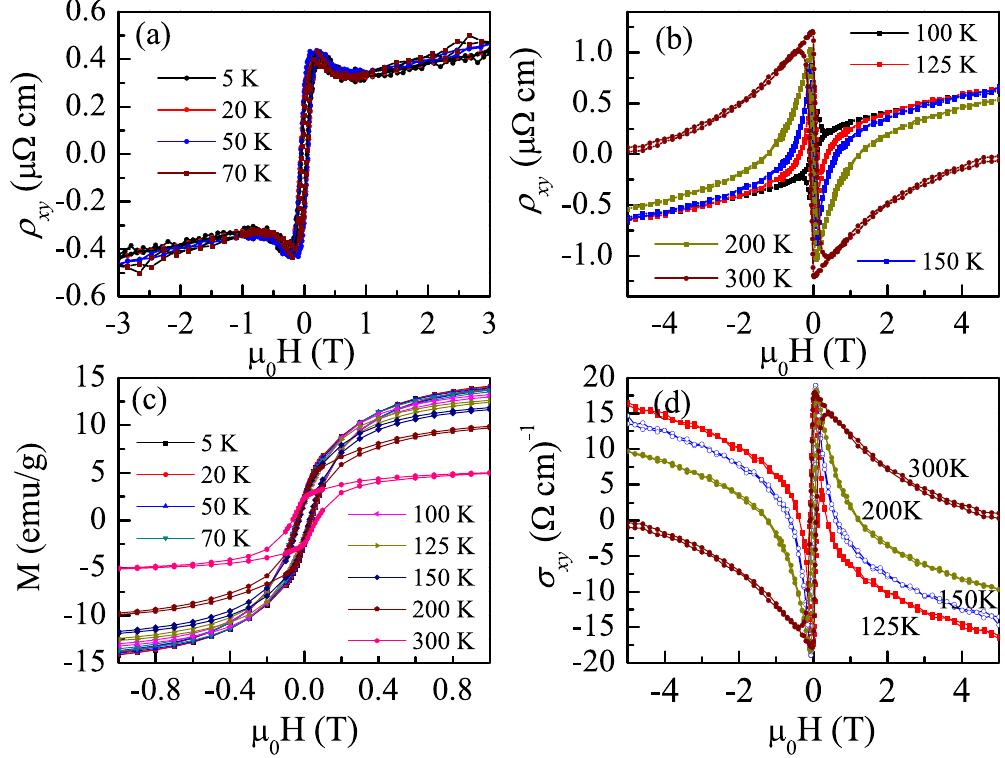
Figure 3. ( a and b ) show Hall resistivity ρ xy as a function of magnetic field at different temperatures, ( c ) is magnetic hysteresis curves at different temperatures, ( d ) shows magnetic field dependence of Hall conductivity σ xy